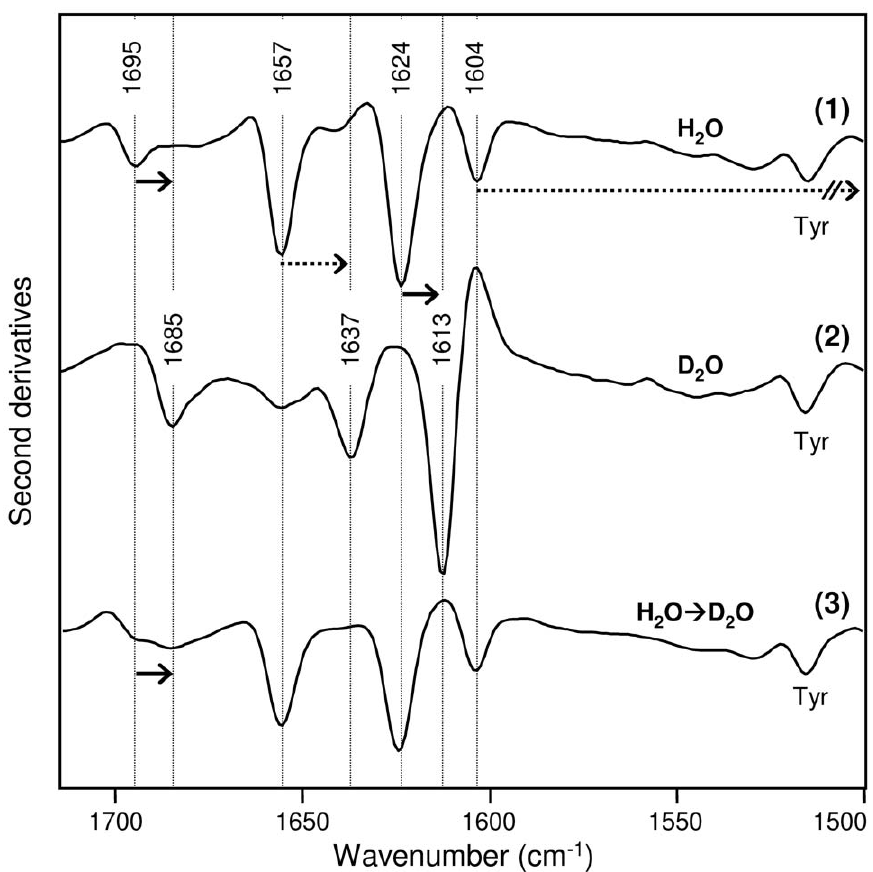
Figure 4. Effect of H/D exchange on FTIR spectra of ATQ55 aggregates. Freshly purified AT3Q55 was incubated in H 2 O/PBS (spectrum 1) and in D 2 O/PBS (spectrum 2) at 37 u C for 168 h. The second derivative spectra of the pelletted aggregates are reported. Upon deuteration, the shift of the cross b -sheet bands (continuous arrows) and the glutamine side chain bands (dotted arrows) are indicated. In a different H/D exchange experiment, freshly purified AT3Q55 was incubated in H 2 O/PBS at 37 u C for 168 h and the obtained mature aggregates were subsequently submitted to three cycles of lyophilization and resuspension in D 2 O, as described in Materials and Methods. Then, the mature aggregates were resuspended in D 2 O and their ATR/FTIR second derivative spectrum recorded (spectrum 3). No appreciable H/D exchange with solvent took places under these conditions, except for the minor one of the 1695 cm 2 1